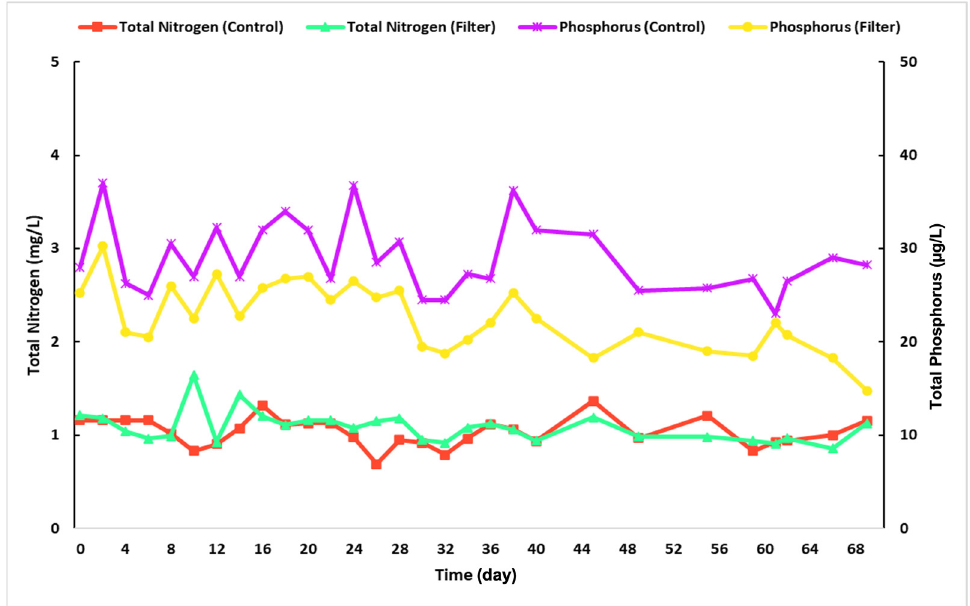
Figure 12. TP concentrations (µg/L) and TN concentrations (mg/L) for the 2019 summer in-situ ex- Figure periment.